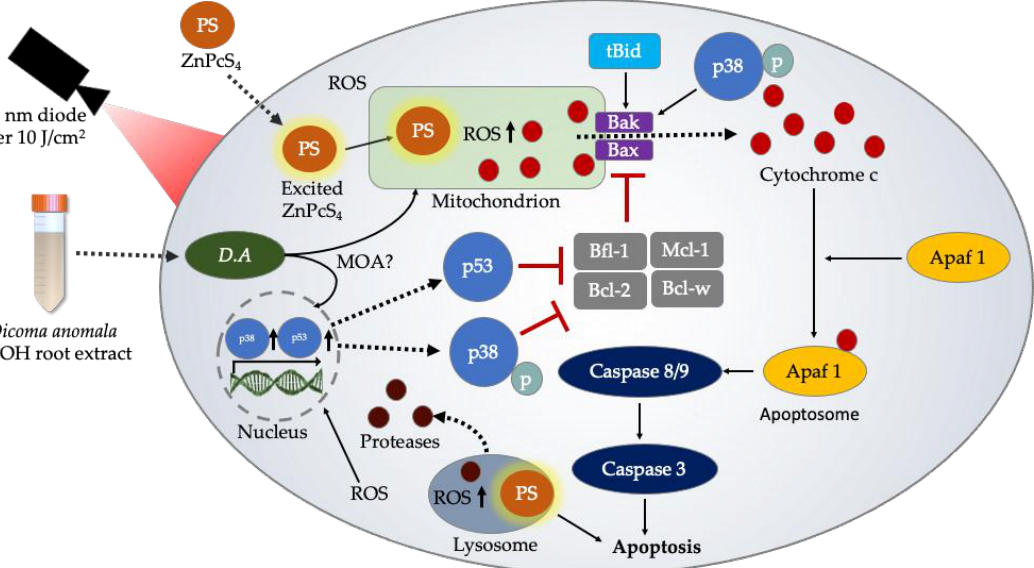
Figure 10. Schematic representation of the proposed intrinsic signaling pathways and cell death mechanism induced by ZnPcS 4 -mediated PDT and D.A MeOH root extract. ROS produced post- irradiation in the cytoplasmic matrix, mitochondria, and lysosomes together with D.A MeOH root extract chemotoxic effects lead to proteolytic and caspase-mediated cascade activation.